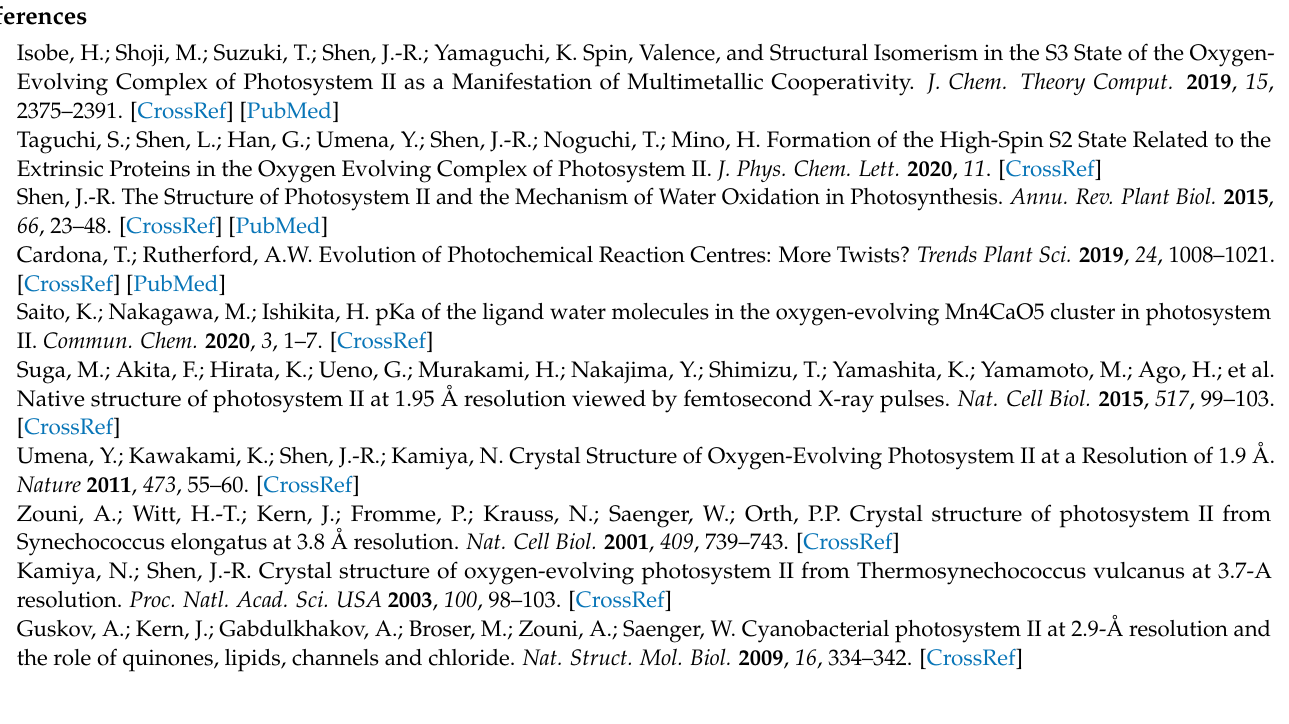
Supplementary Materials: Simulation parameters for Figure 9 (S1) and simulation parameters for Figure 10